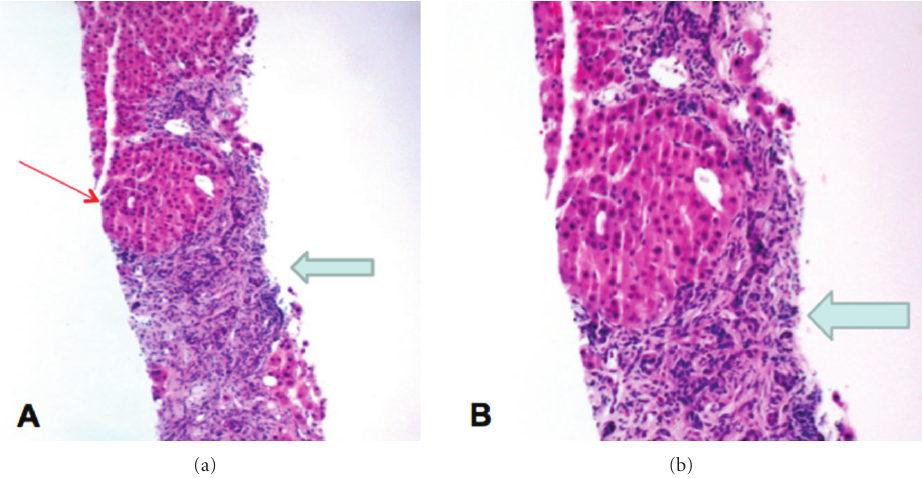
Figure 3: Needle core biopsy of liver mass. (a) Medium power view (5x magnification) demonstrating lobules of hepatic parenchyma (red arrow) separated by broad bands of fibrous connective tissue (blue arrow). (b) Higher power view (10x magnification) demonstrating bile ductular proliferation in the broad fibrous septae.